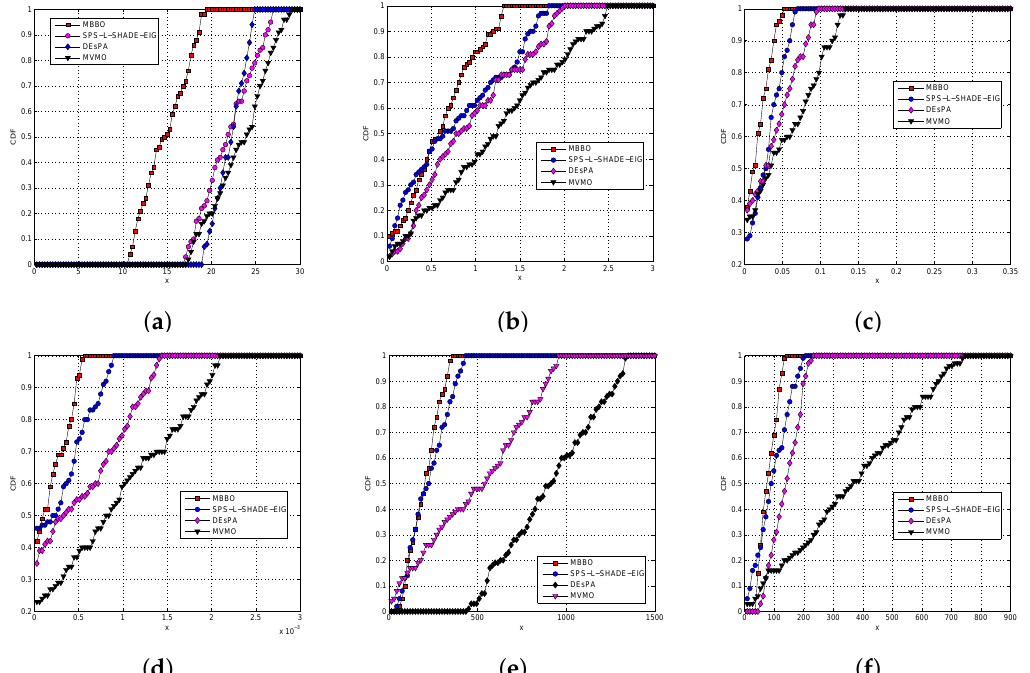
Figure 3. ( a–f ) are the cumulative distribution function (CDF) plots for 10-D function F3, F4, F7, F8, F14 and F15 of MBBO, SPS-L-SHADE-EIG, DEsPA and MVMO algorithms. ( a ) F3; ( b ) F4; ( c ) F7; ( d ) F8; ( e ) F14; ( f )